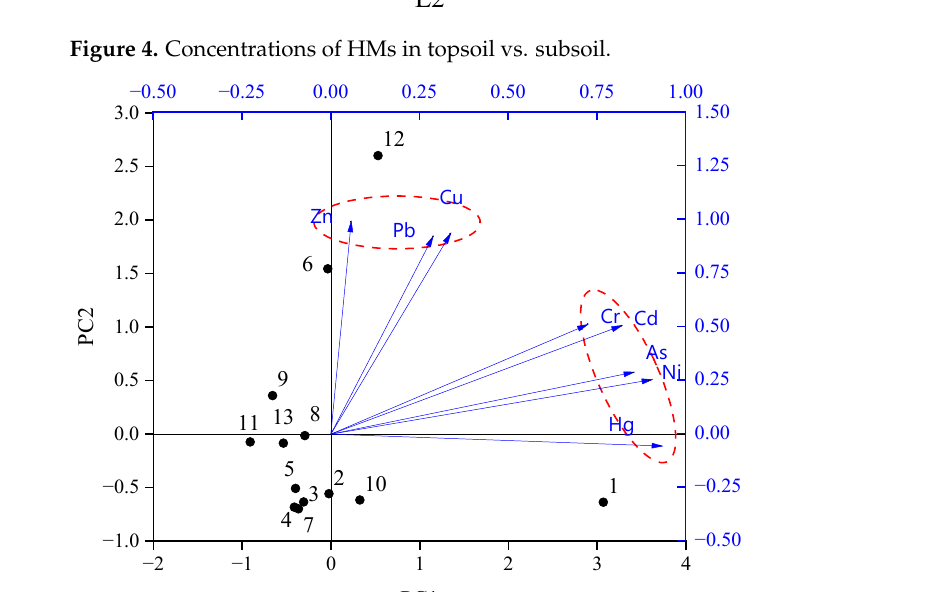
Figure 5. Biplots of sampling points and component 1 with component 2 based on the PCA results.